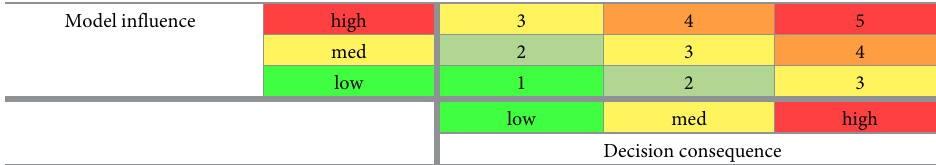
Table 2. Risk map. Adapted from